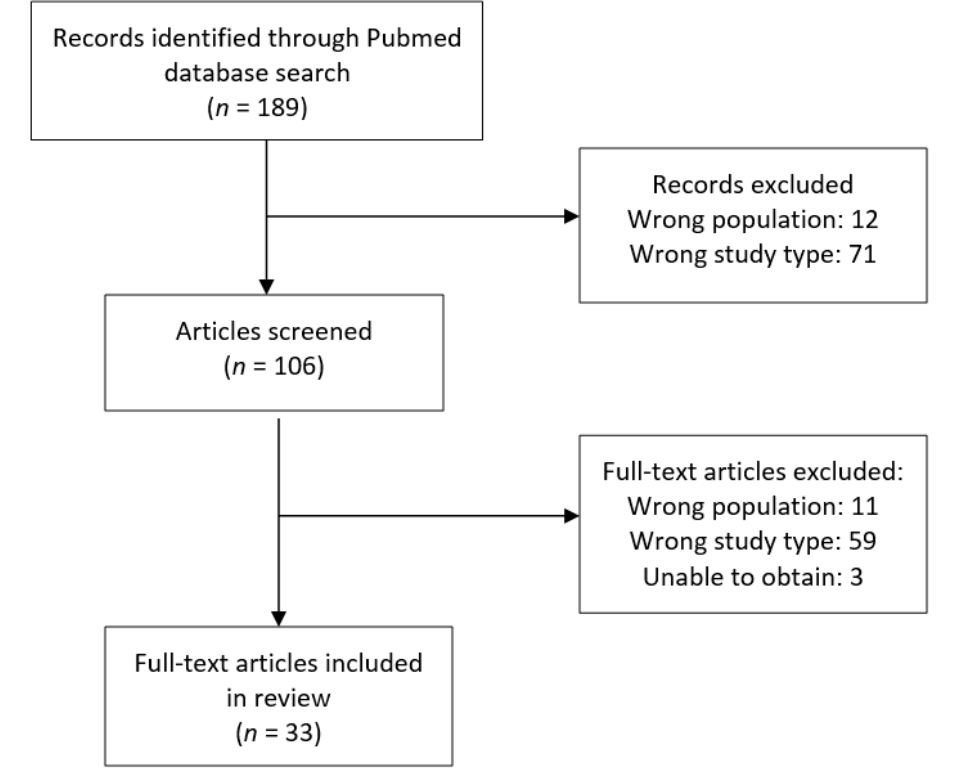
Figure 1. Study Design Methods. Table 1. Studies Using Ultrasound to Assess